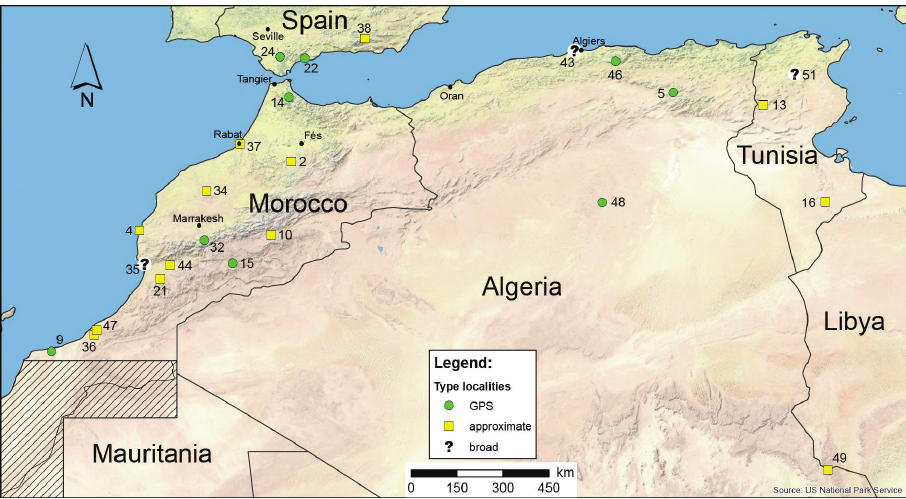
Figure 12. Map of North Africa Maghrebian Buthus species’ type localities (numbers according to the Catalogue and Table 2) whenever known or the best possible approximation at